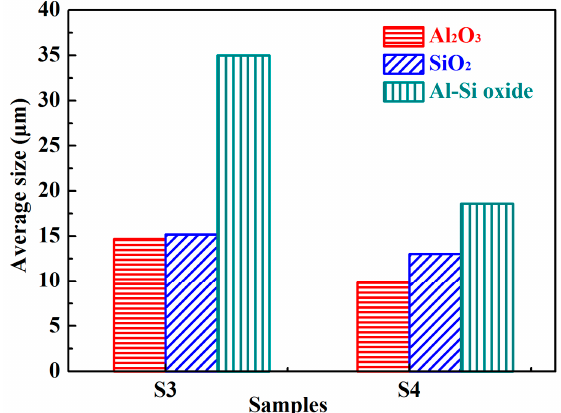
Figure 6. The average sizes of oxide inclusions in the S3 and S4 samples.